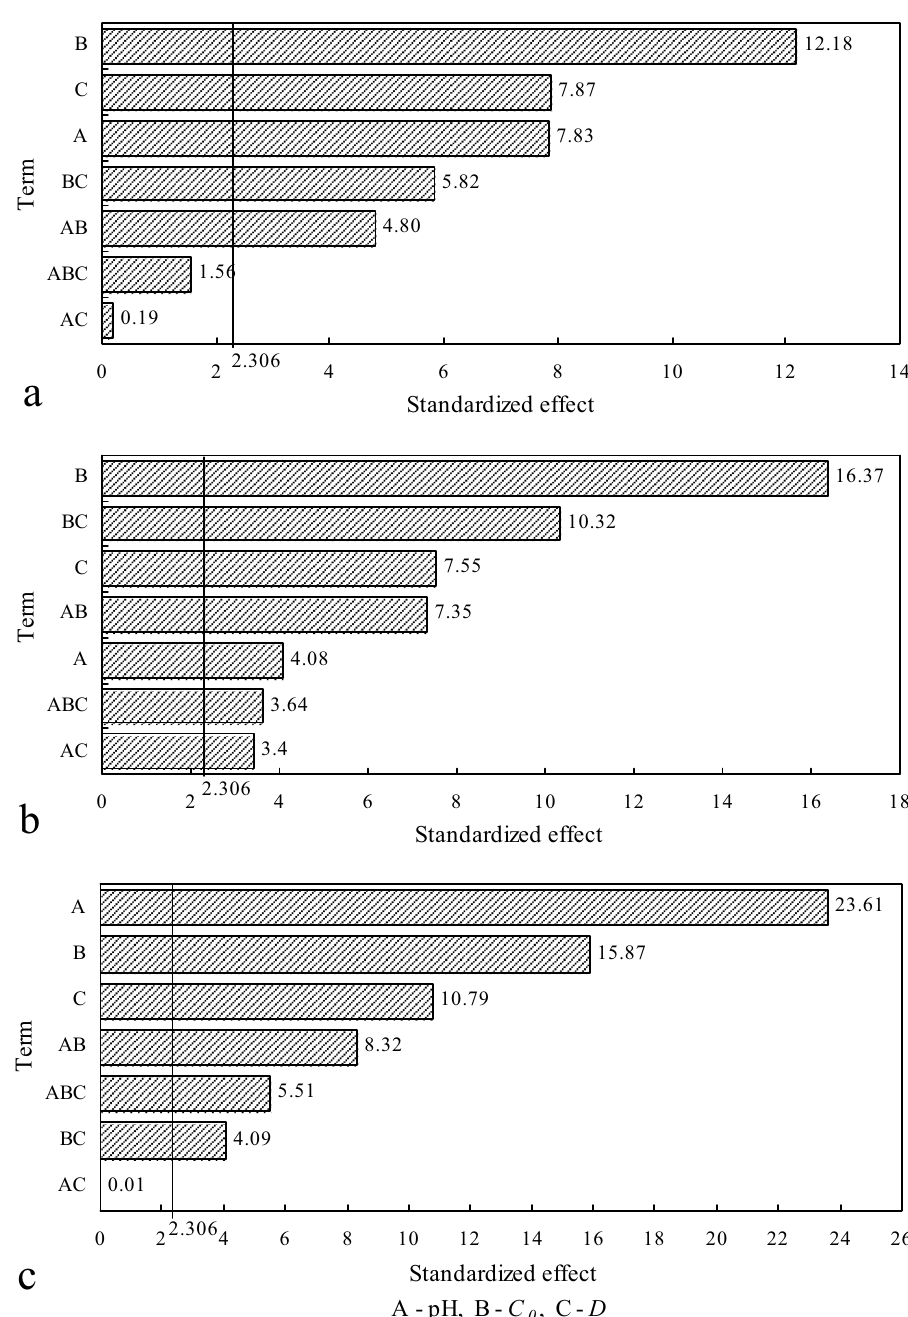
Figure 2. Pareto charts of effects on removal efficiency: ( a ) Cu 2+ , ( b ) Pb 2+ , ( c ) Cd 2+